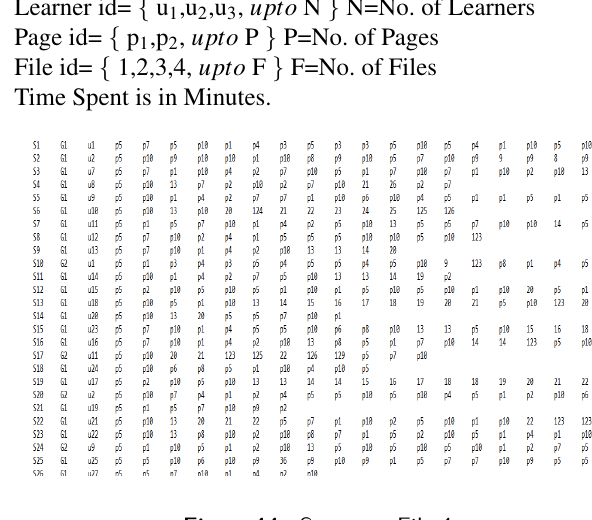
Figure 11. Sequence File 1